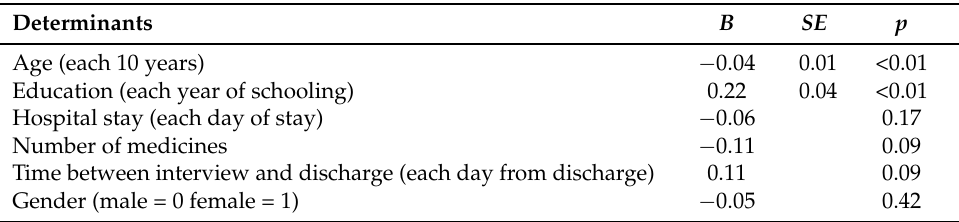
Table 3. Results of multiple linear regression analysis of determinants of medication literacy for discharged patients with ACS, Changsha, Hunan, China, March to June 2015 ( n = 153). Determinants B